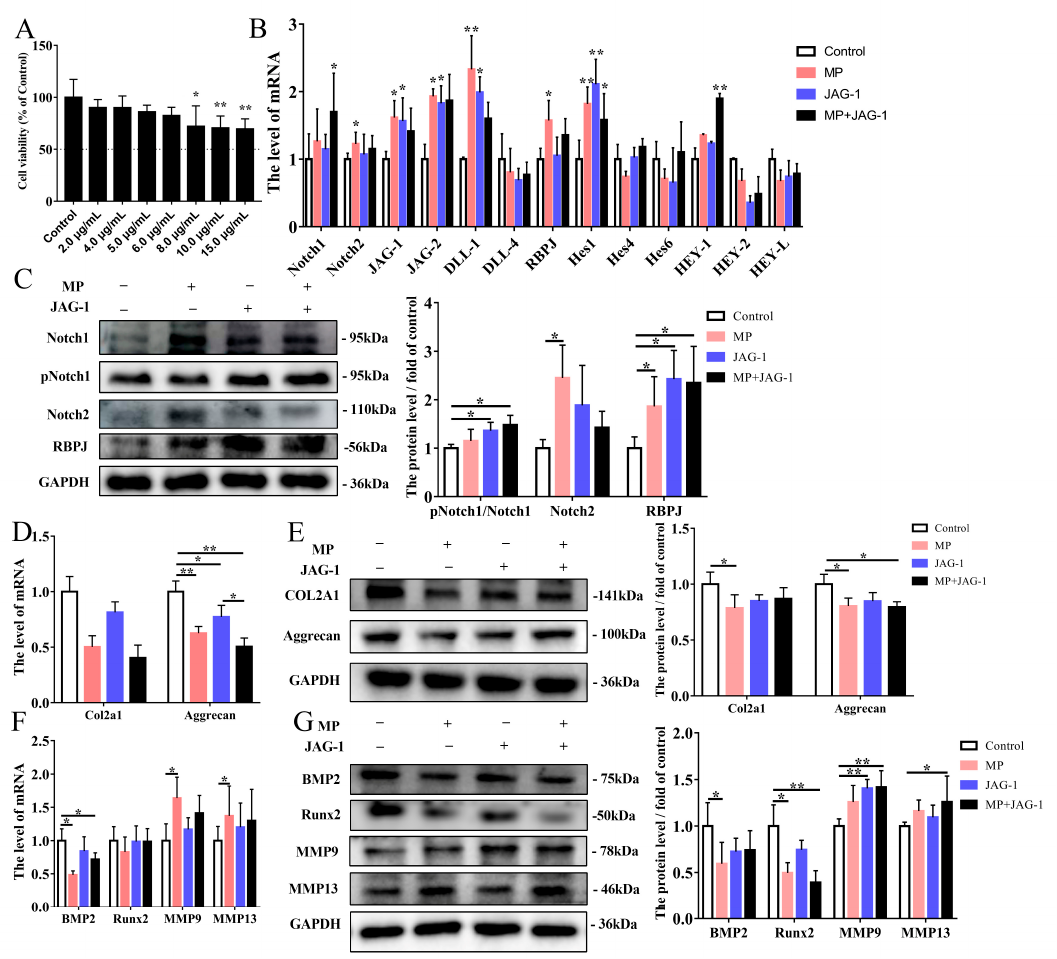
Figure 3. Regulation of MP-induced cell differentiation by JAG-1 activation of the Notch pathway. ( A ) Cell viability under different JAG-1 concentrations in 24 h. ( B ) Effect of JAG-1 on Notch-related genes expression levels in BMSCs. ( C ) The protein expressions of p-Notch1, Notch1, Notch2 and RBPJ were detected by western blo tt ing analysis. ( D – E ) The expression levels of Col2a1 and Aggre- can in BMSCs exposed to MP and JAG-1 were determined by qRT-PCR and western blot. ( F – G ) E ff ects of JAG-1 on the mRNA and protein levels of BMP2, Runx2, MMP9 and MMP13 in BMSCs tested by qRT-PCR and western blot. * p < 0.05 were considered statistically signi fi cant and ** p < 0.01 means extremely signi fi cant.